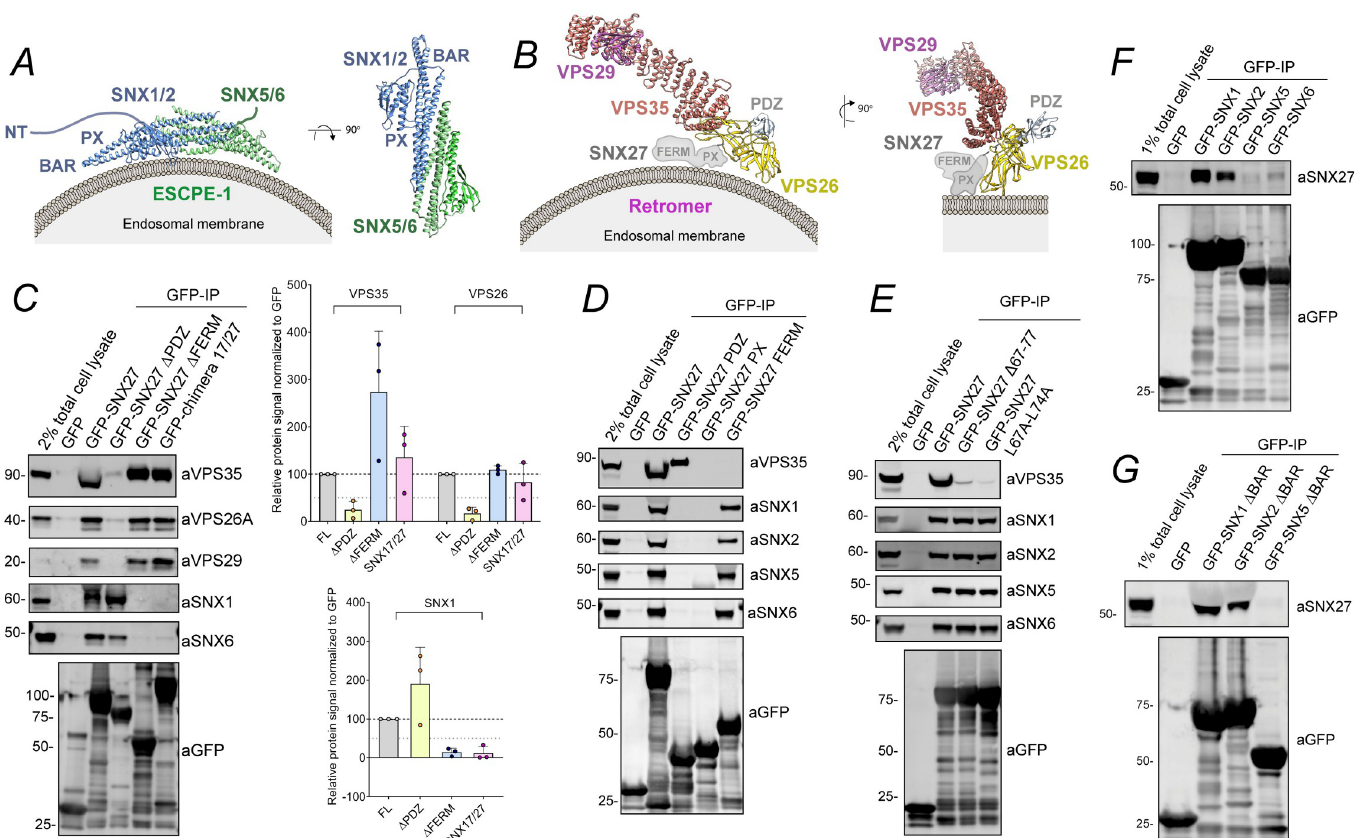
Fig 2. The FERM domain of SNX27 interacts with SNX1 and SNX2. (A) Schematics of ESCPE-1 assembly consisting of heterodimers of the SNX-BAR proteins SNX1 or SXN2 with SNX5 or SNX6. These SNXs have BAR and PX domains responsible of dimer formation and membrane targeting, respectively. SNX1 and SNX2 also have an extended amino-terminal unstructured extension (NT). (B) Schematics of the SNX27–Retromer assembly. Retromer is a stable heterotrimer of VPS35, VPS26, and VPS29. Retromer directly interacts with SNX27 through a β -hairpin insertion within the PDZ domain (residues 67 to 79) that engages a cleft of the VPS26 protein between the amino-terminal and carboxyl-terminal subdomains. (C) Co-immunoprecipitation of GFP-tagged SNX27 FL, SNX27 Δ PDZ, SNX27 Δ FERM and a chimera consisting of the SNX27 gene where its FERM domain was swapped for that of SNX17. The constructs were transiently transfected in HEK-293T cells, the cell lysates were subjected